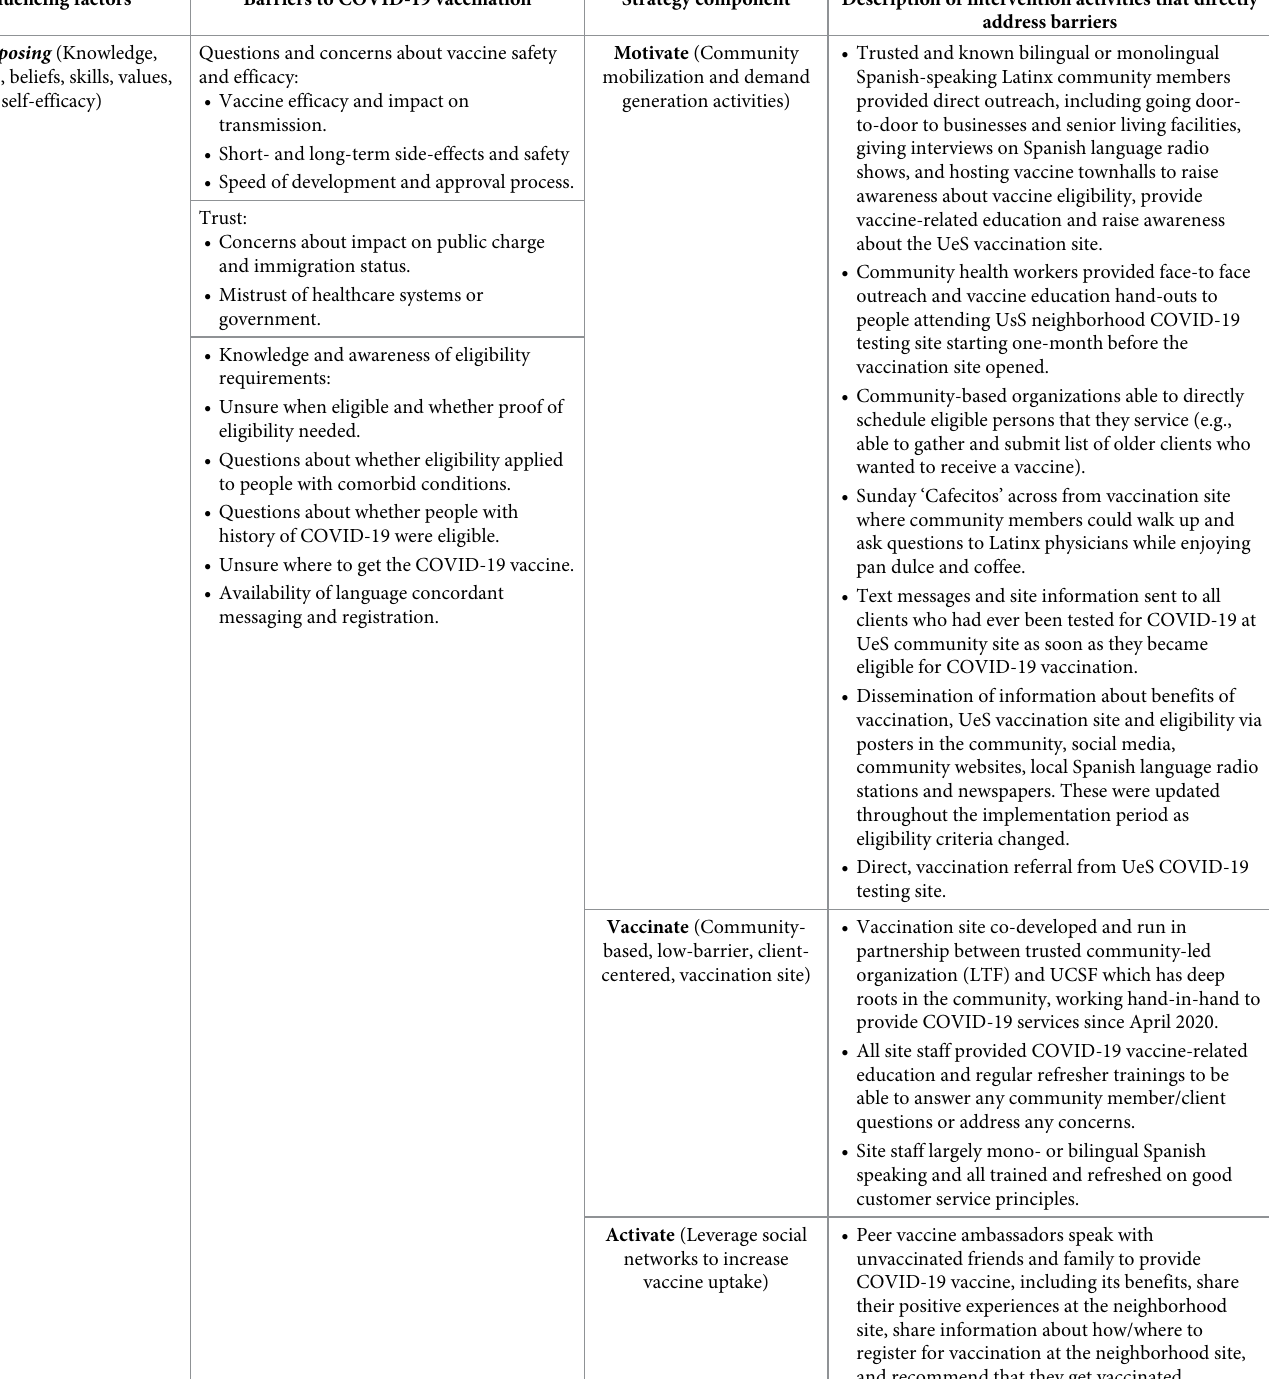
Table 1. Description of the “Motivate, Vaccinate, and Activate” strategy to address predisposing, enabling and reinforcing factors to COVID-19 vaccination among low-income Latinx